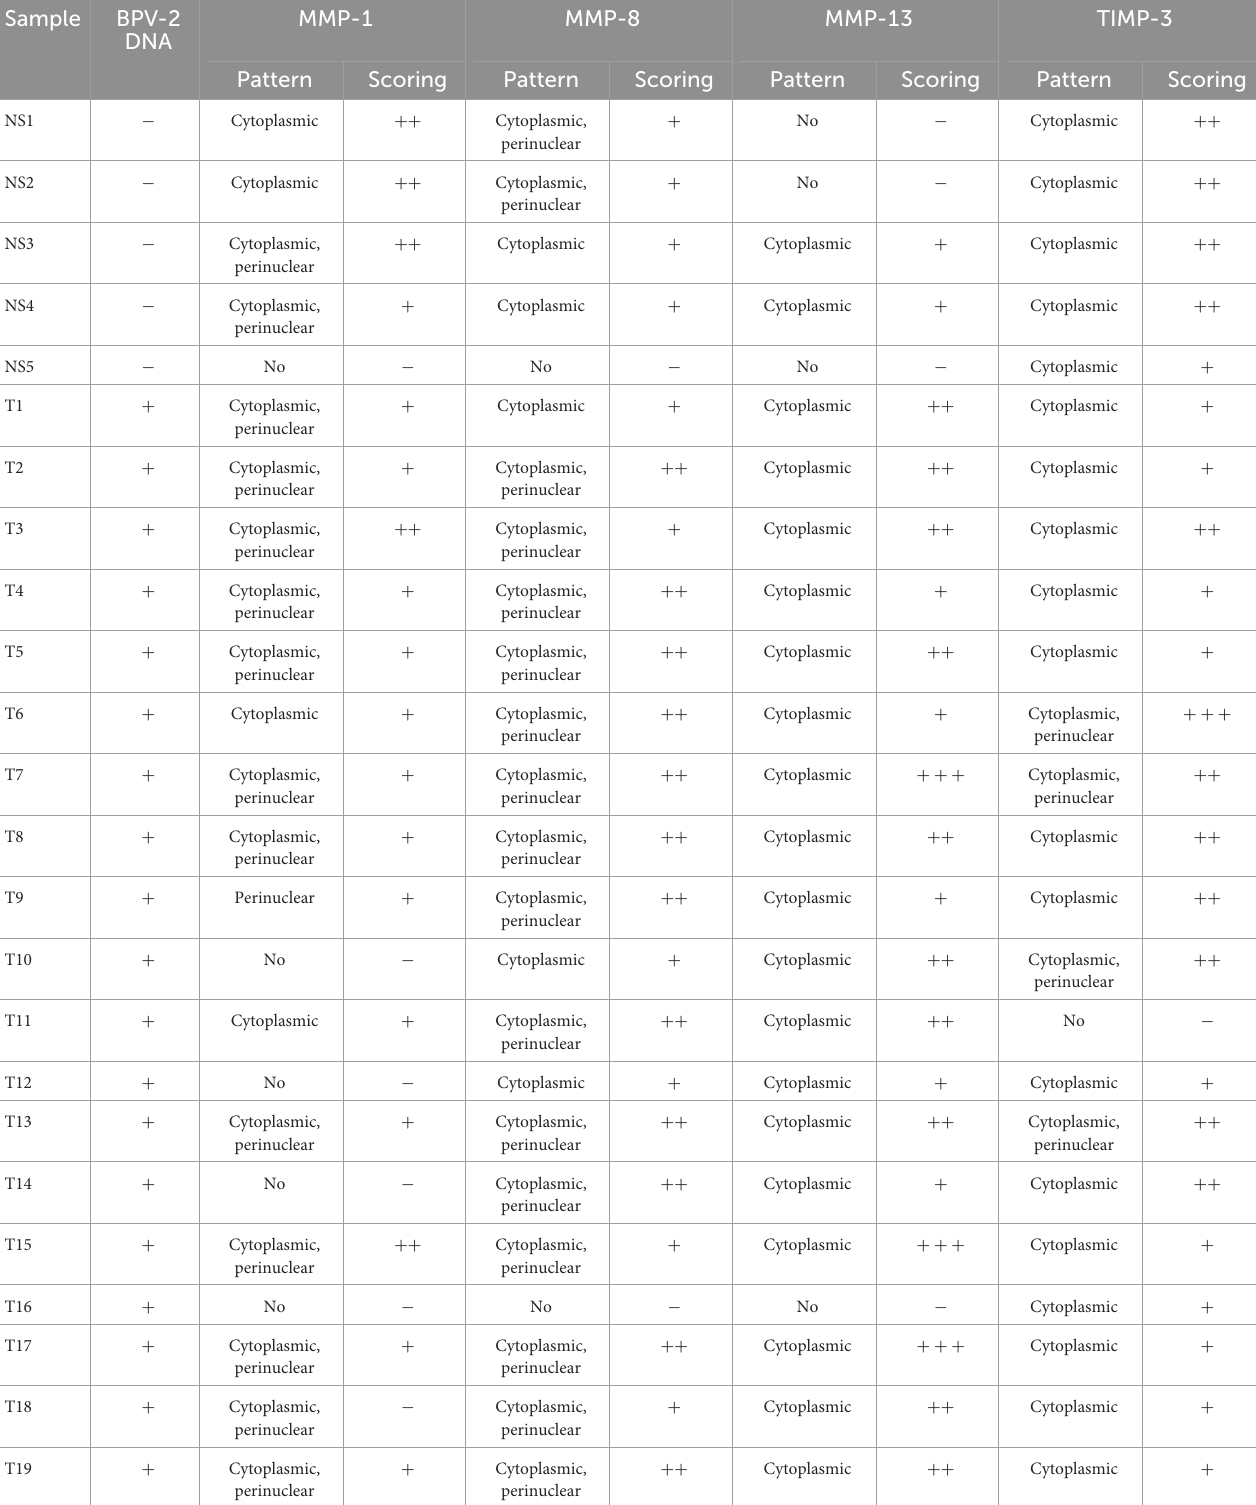
TABLE 1 BPV DNA presence and collagenases (MMP-1/-8/-13) and TIMP-3 protein expression in normal skin and bovine cutaneous fibropapillomas.